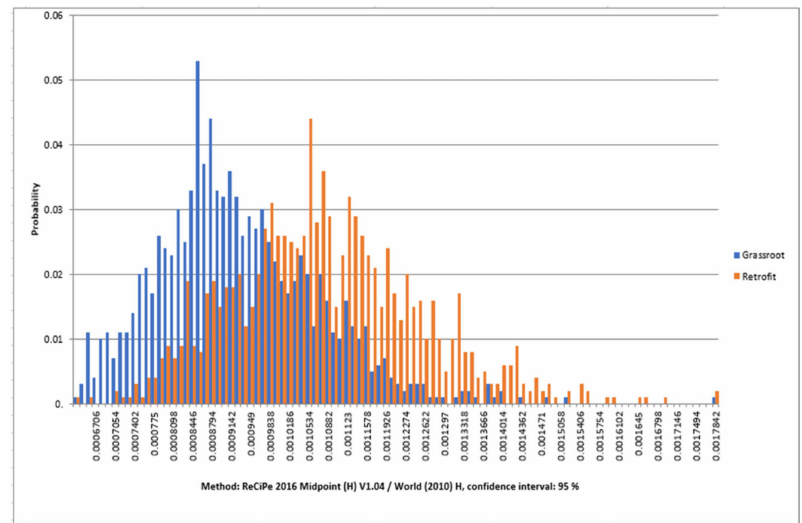
Figure 12. Distribution of probability index of AP.